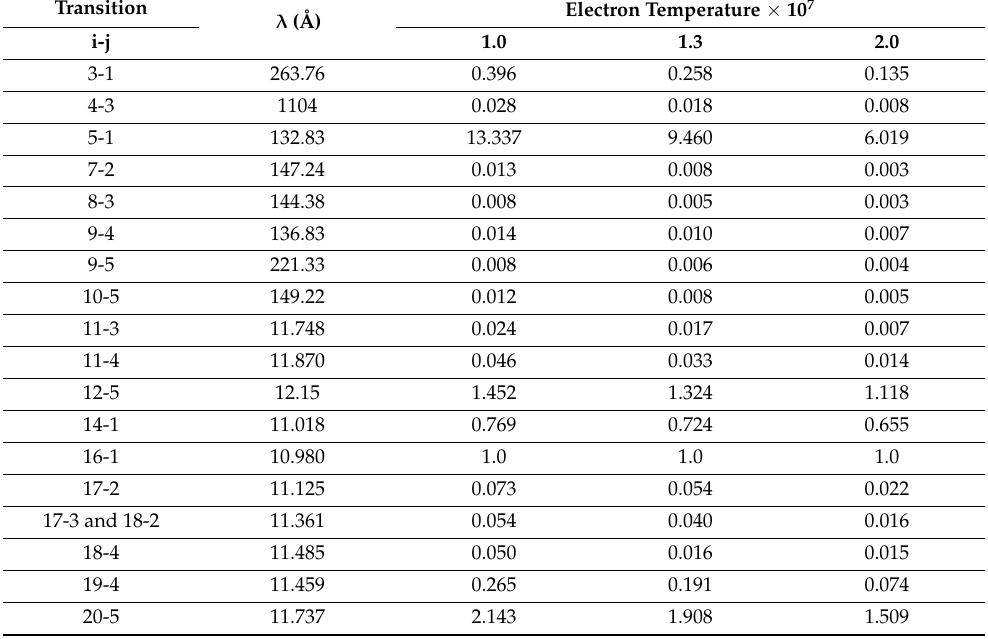
Table 16. Intensity ratios of UV and X-ray